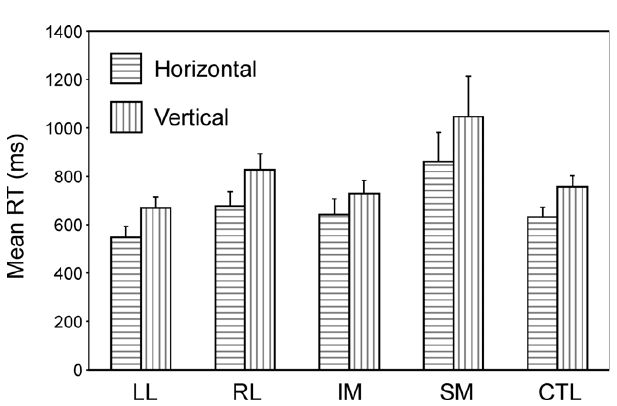
Figure 3. Single task conditions. Mean reaction times and standard errors for the four patient groups and the controls on the two tasks (horizontal and vertical).